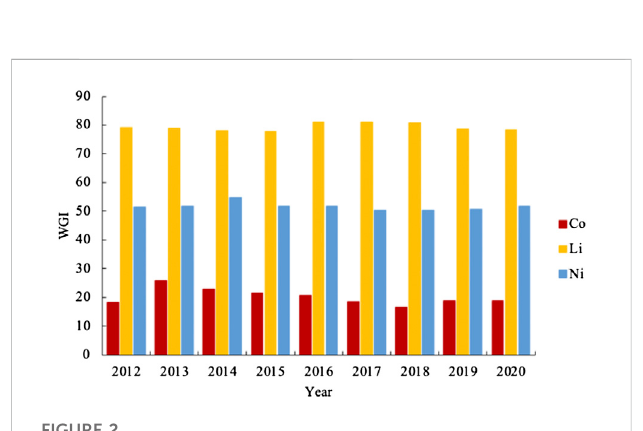
FIGURE 2 Comprehensivetrend oflithium, cobalt, and nickelresourcesupply risk index based on